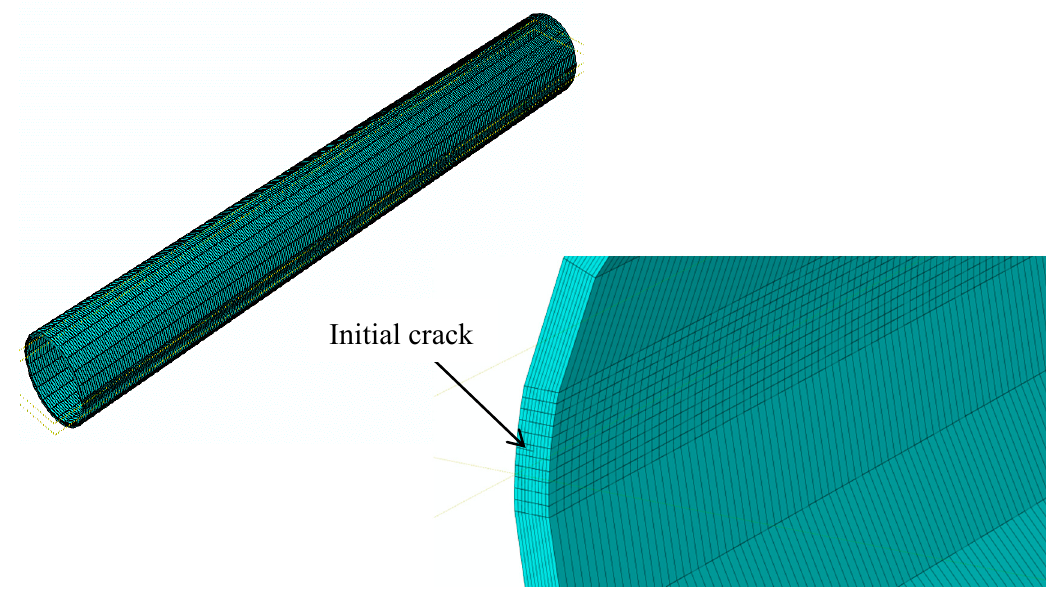
Figure 13. Finite element model of a hydraulic pipe with a semi-penetrating initial crack.